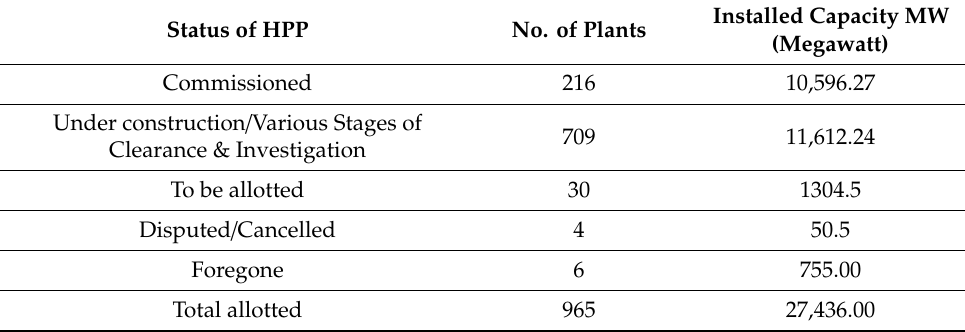
Table 1. Status of hydropower project (HPP) potential in various river basins and its sub-basins as of December 2019 (Source: Directorate of Energy, Govt. of Himachal